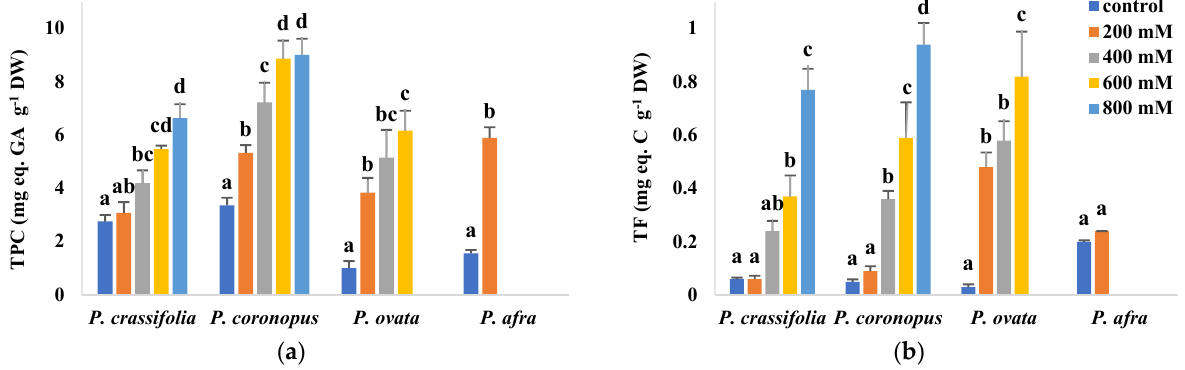
Figure 8. Leaf contents of total phenolic compounds (TPC) ( a ) and total flavonoids (TF) ( b ) in the four selected Plantago species, after four weeks of treatment with the indicated NaCl concentrations. The values shown are means ± SE ( n = 5). For each species, different letters over the bars indicate significant differences between treatments, according to the Tukey test ( p < 0.5). GA: gallic acid; C. catechin.